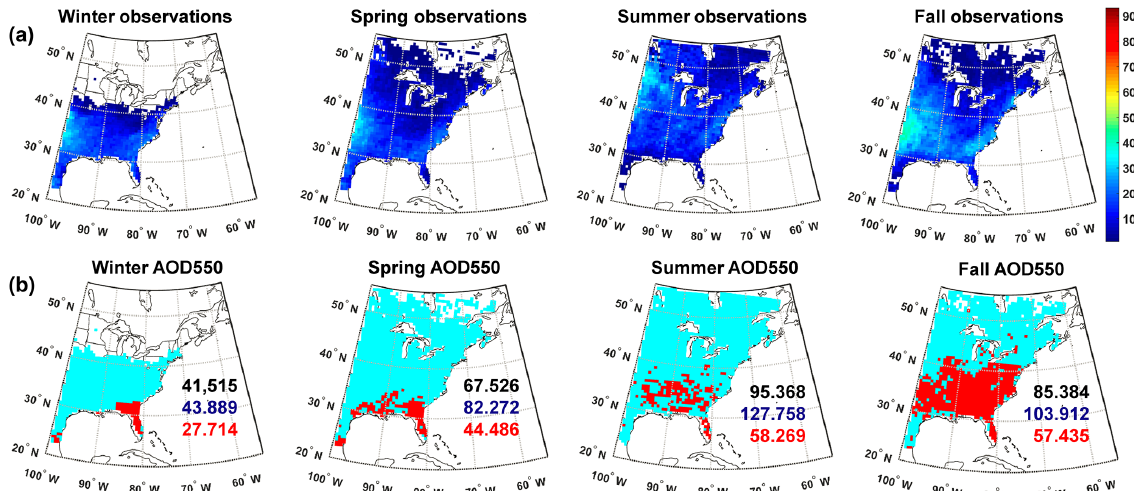
Figure 2. First line: number of paired AOD observations at a wavelength ( λ) of 550nm (i.e., simultaneous values as output from WRF-Chem and observed by MODIS) used to perform a t test designed to evaluate whether the difference computed for each grid cell as WRF60-MODIS differs from that computed as WRF12-remap-MODIS on a seasonal basis (columns show winter, DJF, spring, MAM, summer, JJA, and fall, SON). Second line: results of the t test. Pixels that have p values that are significantly different at α = 0 . 10 are indicated in red and have been corrected for multiple testing using a false discovery rate approach. The number of observations of cloud-free conditions summed across all days in each season and all grid cells is also reported (black = MODIS, blue = WRF60, red =